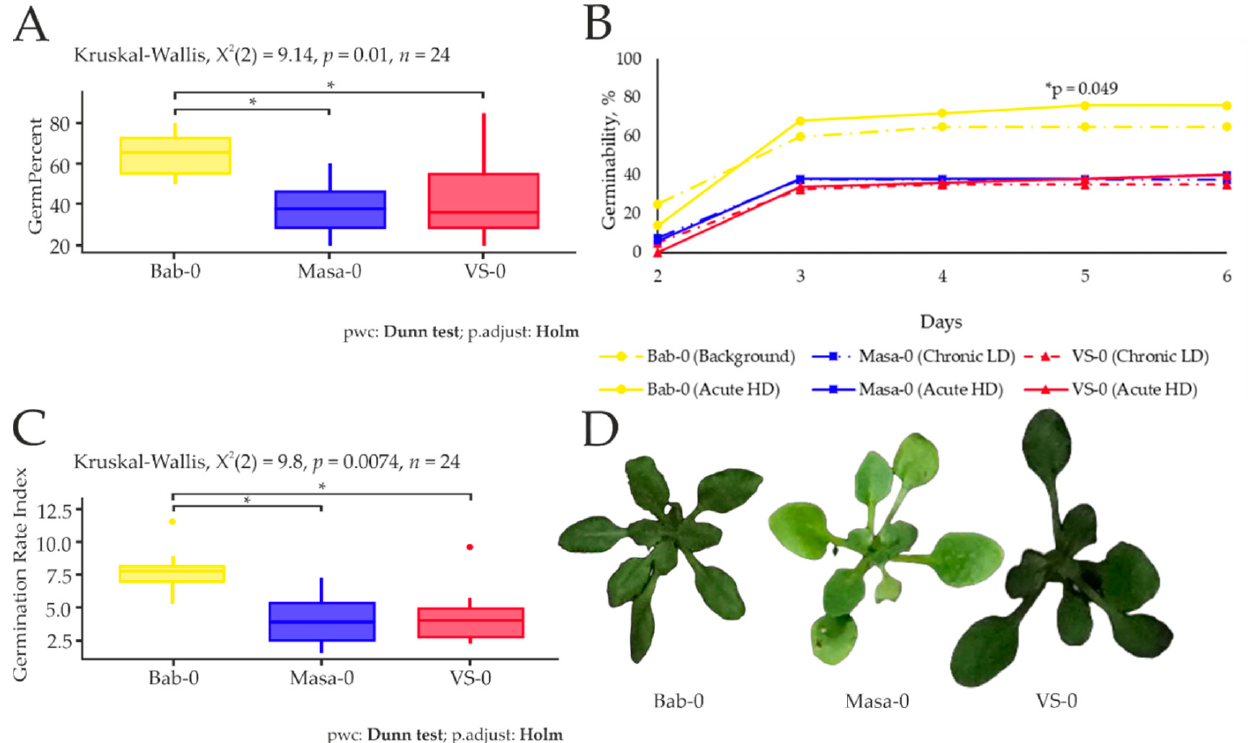
Figure 2. ( A ). Germinability, %, of seeds collected from the Babchin (Bab-0), Masany (Masa-0), Vygrebnaya Sloboda (VS-0) plots. ( B ). Germinability (%, at days 2–6 after seed transfer to the growth chamber. Bab-0 (Background), Masa-0 (Chronic LD) and VS-0 (Chronic LD)—seeds collected from the experimental plots Babchin, Masany, and Vygrebnaya Sloboda, respectively; Bab-0 (Acute HD), Masa-0 (Acute HD) and VS-0 (Acute HD)—seeds collected from the experimental plots and exposed to acute γ -irradiation at a dose of 150 Gy. ( C ). Germination Rate Index, seed × days − 1 , of seeds collected from Babchin (plot with background radiation level) and radioactively contaminated plots Masany and Vygrebnaya Sloboda. ( D ). A. thaliana plants from the experimental plots. The graphs were created using RStudio v1.4 (R-Tools Technology, Richmond Hill, ON, Canada). Data are presented for two independent experiments with four biological replicates in each (20 seeds per replicate for each accession). *—significant differences at p < 0.05 (( A , C )—Kruskal–Wallis test with Dunn’s test using the Holm–Bonferroni correction for multiplicity; ( B )—irradiated compared to control, Mann–Whitney U -test).